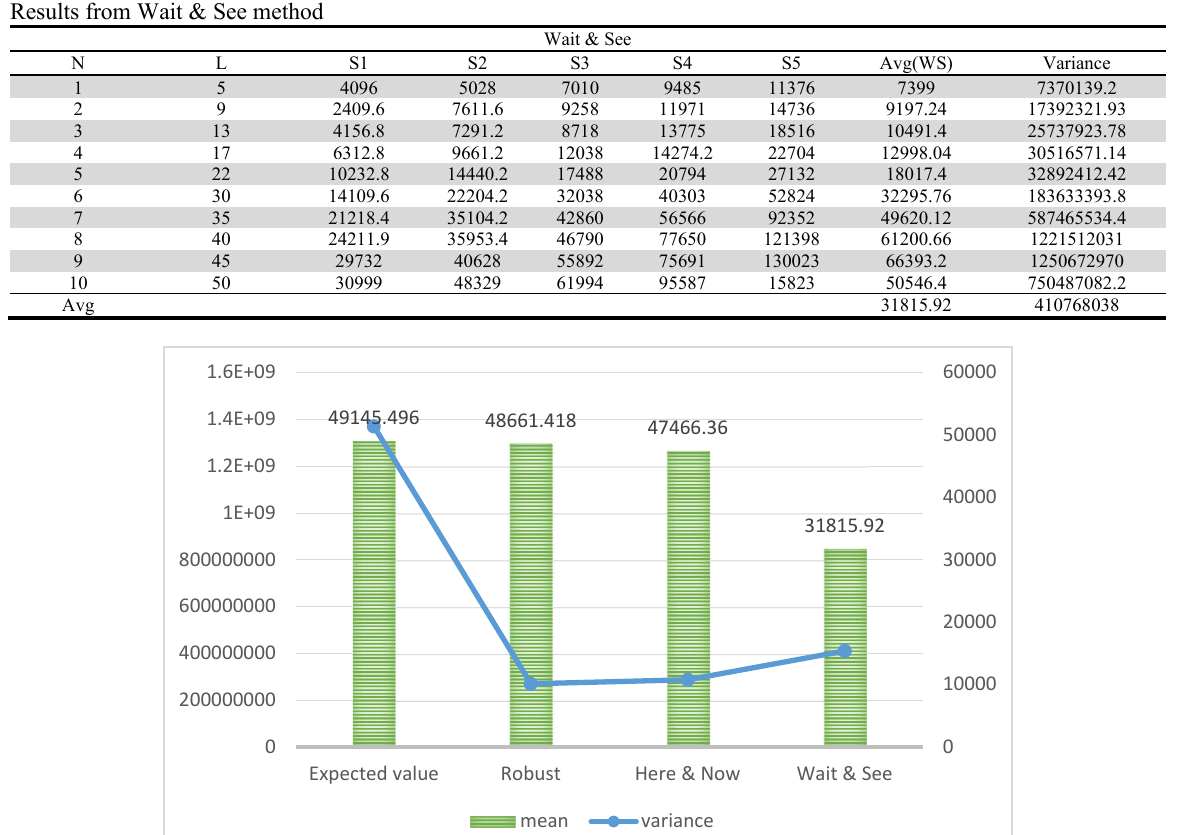
Fig. 10. The of mean and variance obtained from different scenarios in different